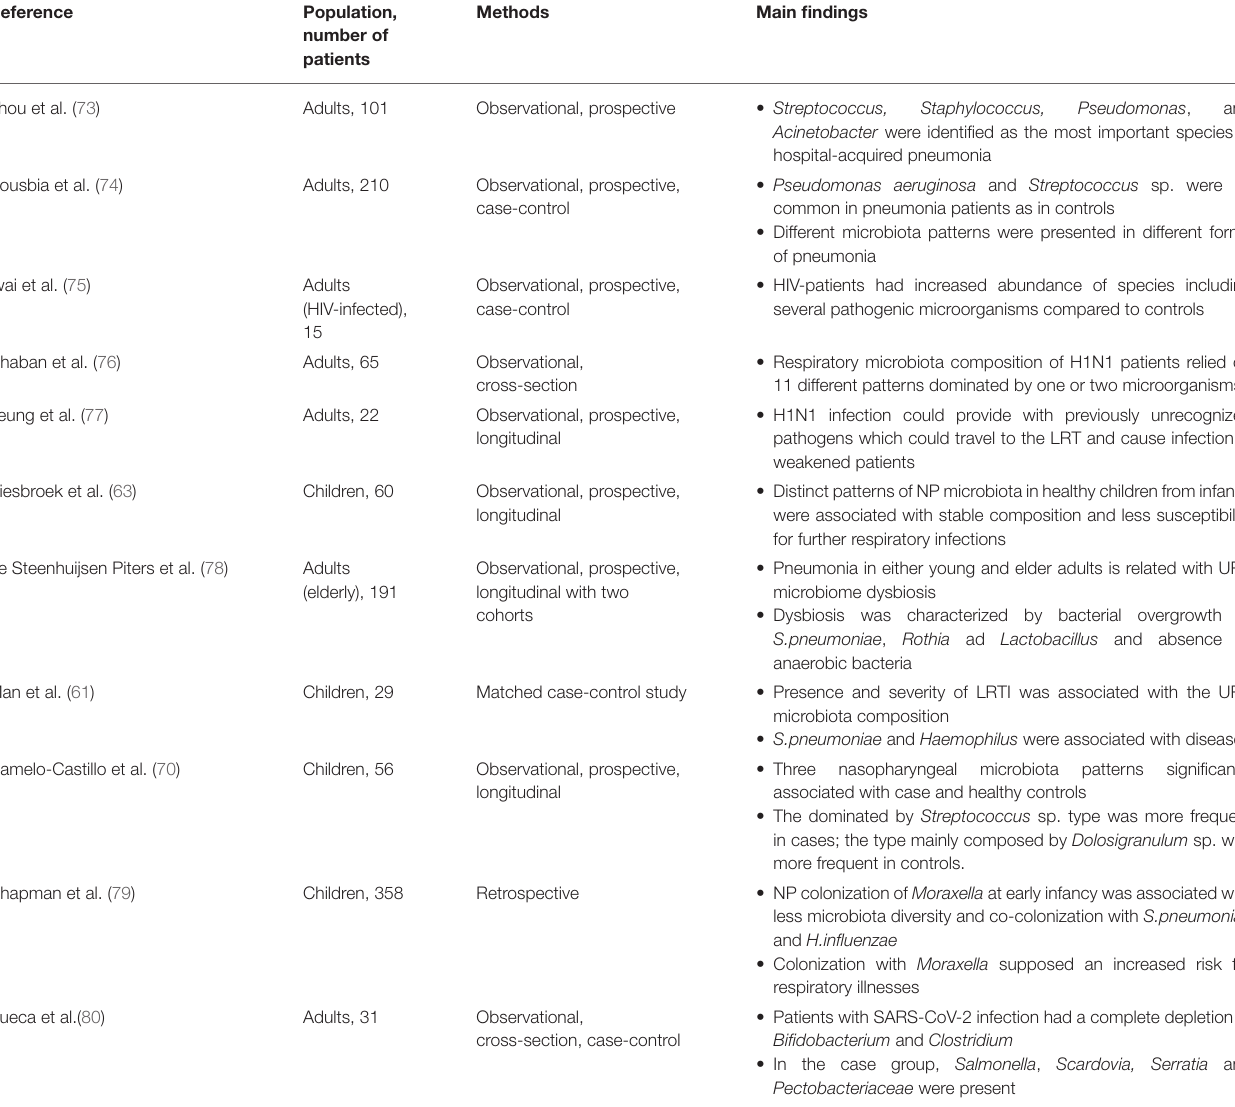
TABLE 1 | Studies of respiratory microbiota related to lower respiratory tract